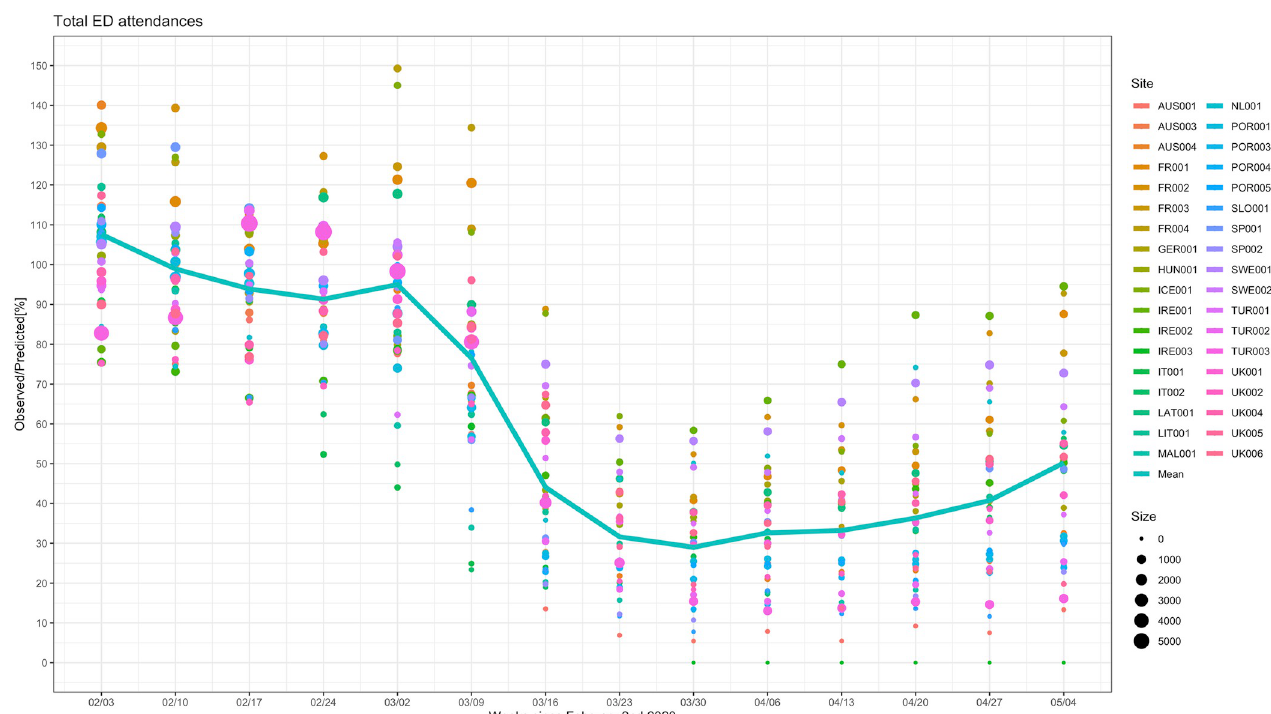
Fig 2. Observed versus predicted ED attendances (%). The observed versus predicted number of children presenting to EDs in countries across Europe in the weeks following February 2, 2020 until May 11, 2020, for all sites combined. The color and the size of the dots reflect the actual number of ED attendances for each site and for each time window. The line connects the mean of the observed vs. predicted point estimates for each of the individual sites for each time window.